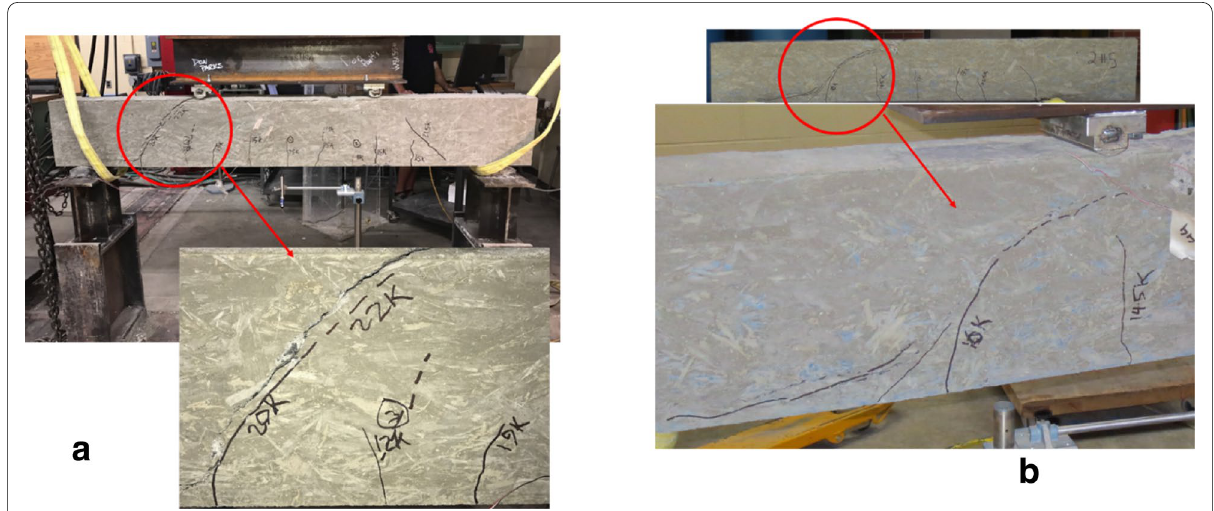
Fig. 5 Failure mode of beam specimens ( a ) 3CONT-MN-2 and ( b )